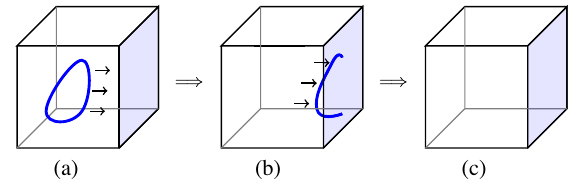
FIG. 3. A dual-condensing boundary can absorb a dual-loop excitation. (a) A dual-loop excitation in the bulk is depicted in blue, while the dual-condensing boundary is shaded light blue. (b) The loop is moved to the boundary, where part of it is absorbed. (c) The loop is fully absorbed.